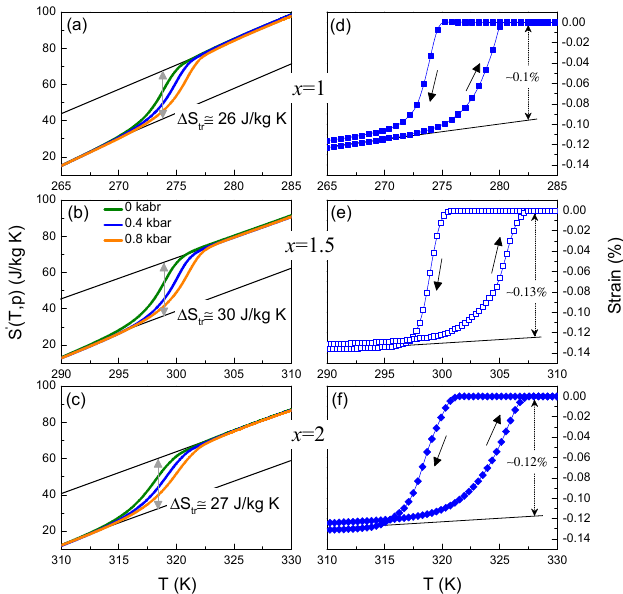
Figure 4. ( a – c ) The relative entropy as function of temperature across the forward transforming range under selected hydrostatic pressures for Co 50 V 34 Ga 16 − x Fe x alloys; the vertical double arrow represents the transition entropy change ( ∆ S tr ). ( d – f ) The spontaneous strain of these alloys measured in the process of forward and reverse MTs.